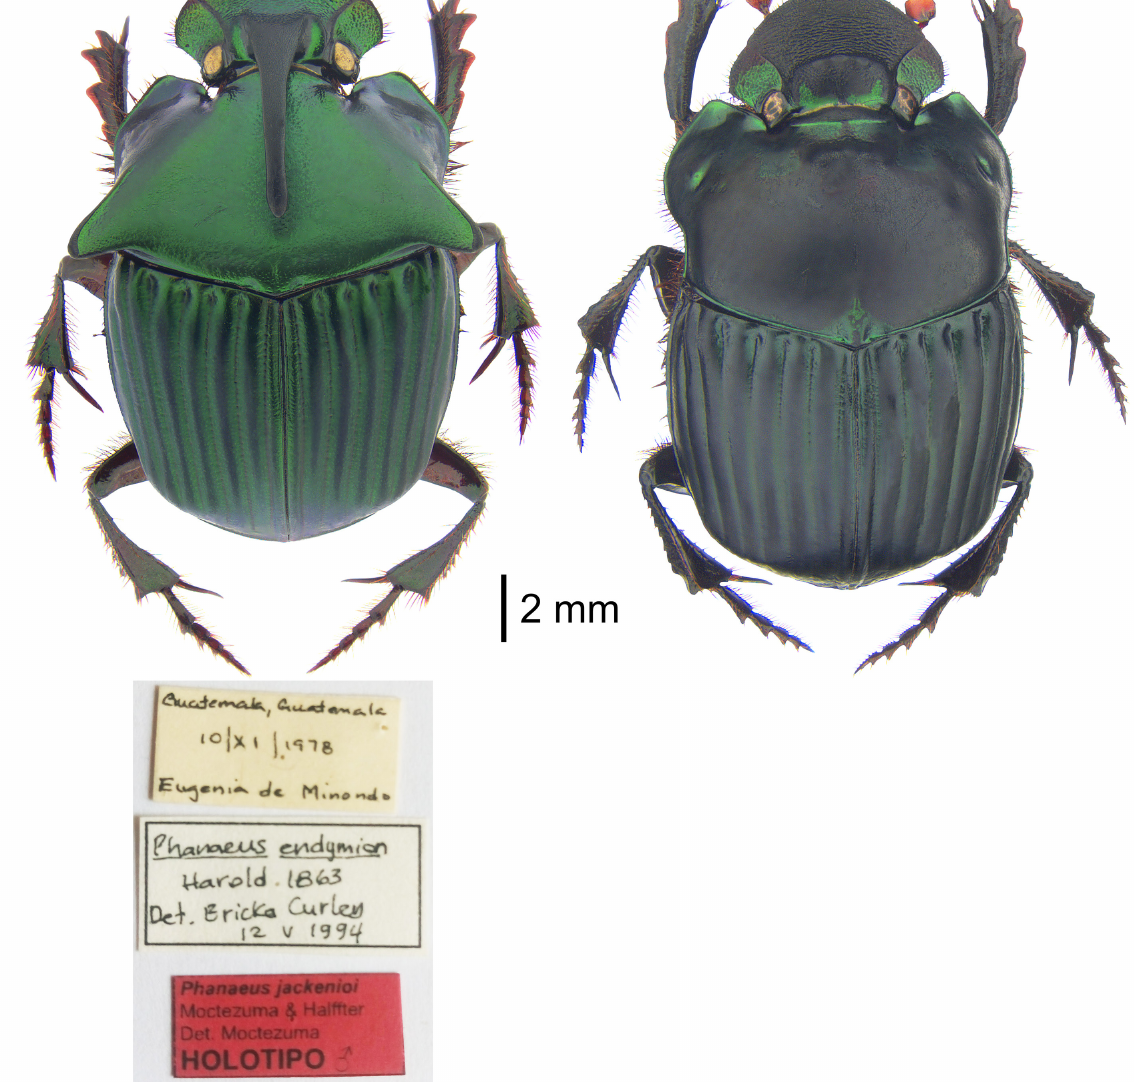
Fig. 6. Phanaeus jackenioi sp. nov. A . Holotype, ♂ (UVGC). B .